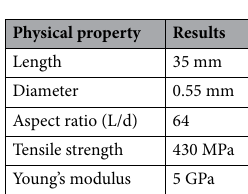
Table 4. Physical property of nylon.